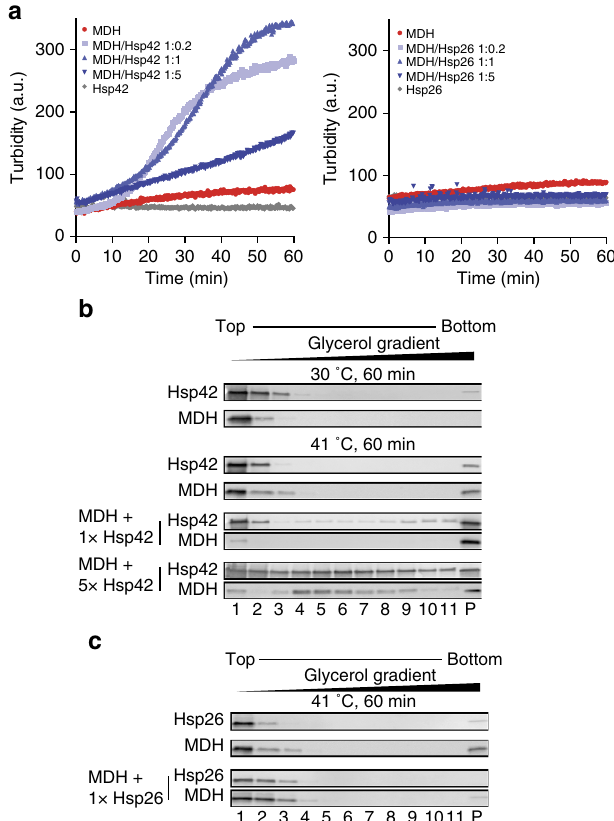
Figure 5 | Hsp42 promotes MDH aggregation under mild denaturation conditions. ( a ) MDH (0.5 m M) was denatured for 60min at 41 (cid:2) C in the absence or presence of sHsps at various ratios (0.1–2.5 m M). As control 2.5 m M sHsps were heated alone. The formation of turbid MDH aggregates was followed at 600nm. ( b , c ) Samples were prepared as described above, loaded onto a 10–50% glycerol gradient and ultracentrifuged at 40,000 r.p.m. for 1h at 4 (cid:2) C. Fractions were analysed by SDS–PAGE followed by western blot analysis (see also Supplementary Fig. 12 for uncropped